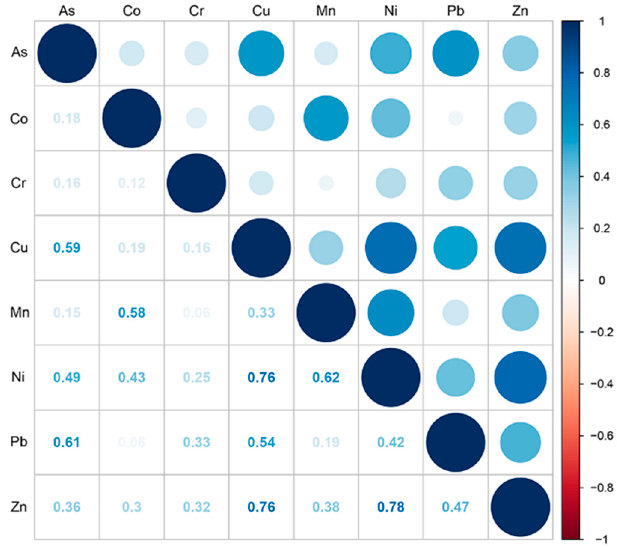
Figure 6. The correlation analysis of PHEs in 0–40 cm soil layer.